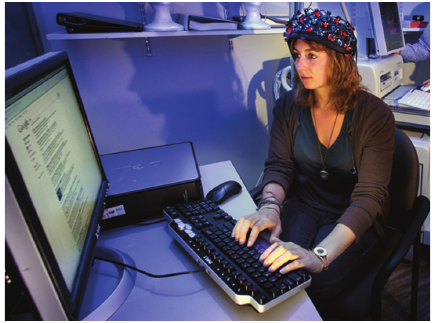
Figure 1: A subject wearing a 52-channel fNIRS